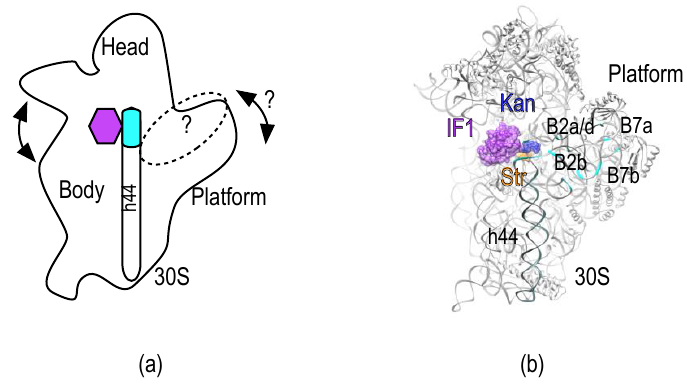
Figure 1. 30S subunit, dynamic domains, and inter-subunit bridges. ( a ) Representation of the 30S subunit as seen from the 50S-interacting side. The main dynamic domains of the small subunit are indicated. Arrows represent the known and potential movements involved in mistranslation of the mRNA. The purple hexagon indicates the decoding center and binding site of IF1, streptomycin and kanamycin. The dotted oval indicates the overall binding surface of IF3 on the 30S platform. ( b ) Crystal structure of the IF1-30S subunit complex (Purple surface, PDB: 1HR0) [13]. Streptomycin (orange) and kanamycin (blue) were aligned from PDB: 4DR3 and PDB: 2ESI, respectively [14,15]. Cyan ribbons highlight residues involved in inter-subunit bridges of the 30S platform that overlap with IF3 binding sites.